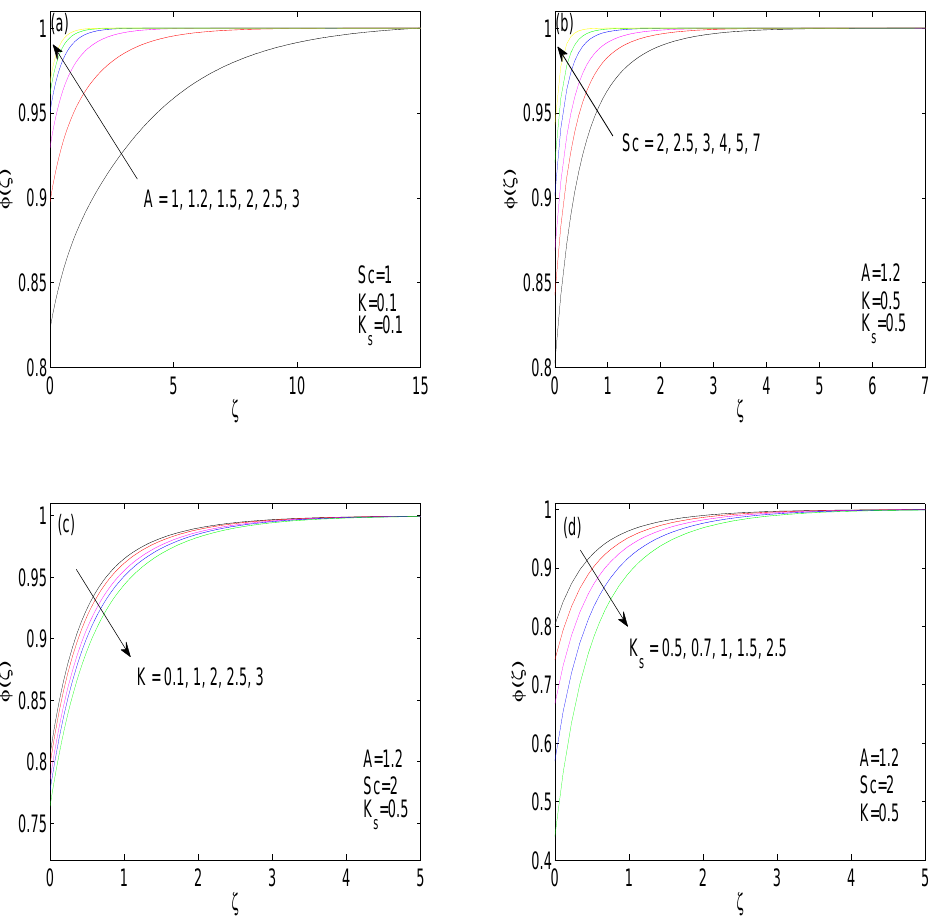
( φ ) for di ff erent values of embedded parameters. Figure 3. Concentration profile (𝜙) for different values of embedded parameters. Figure 3. Concentration profile